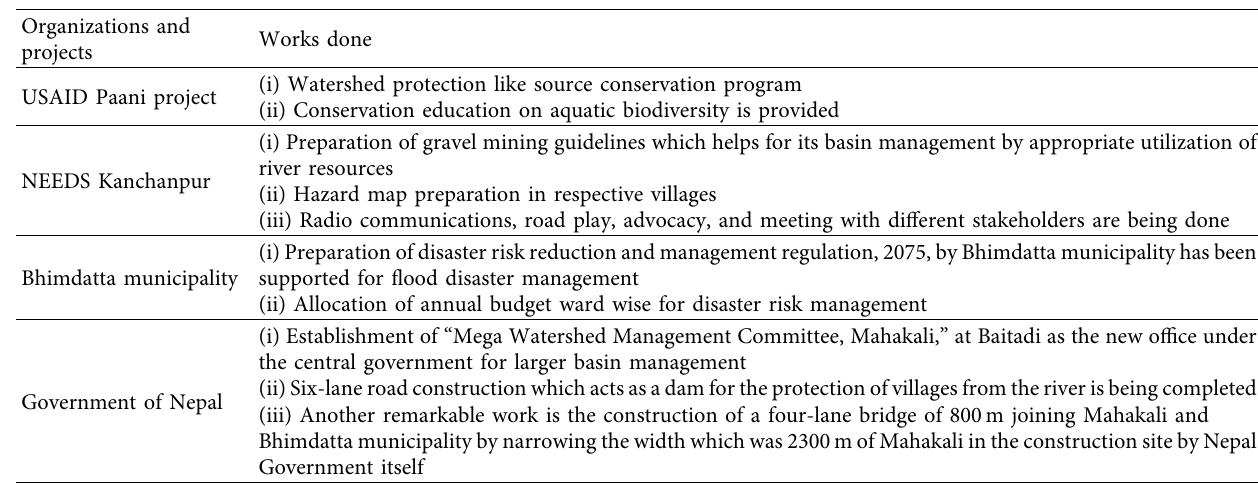
Table 2: Present scenario of flood and watershed management.